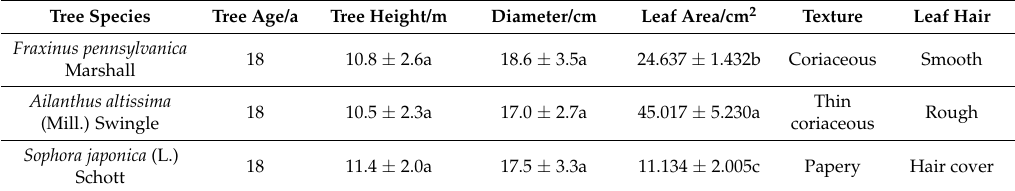
Table 1. Leaf traits of three tree